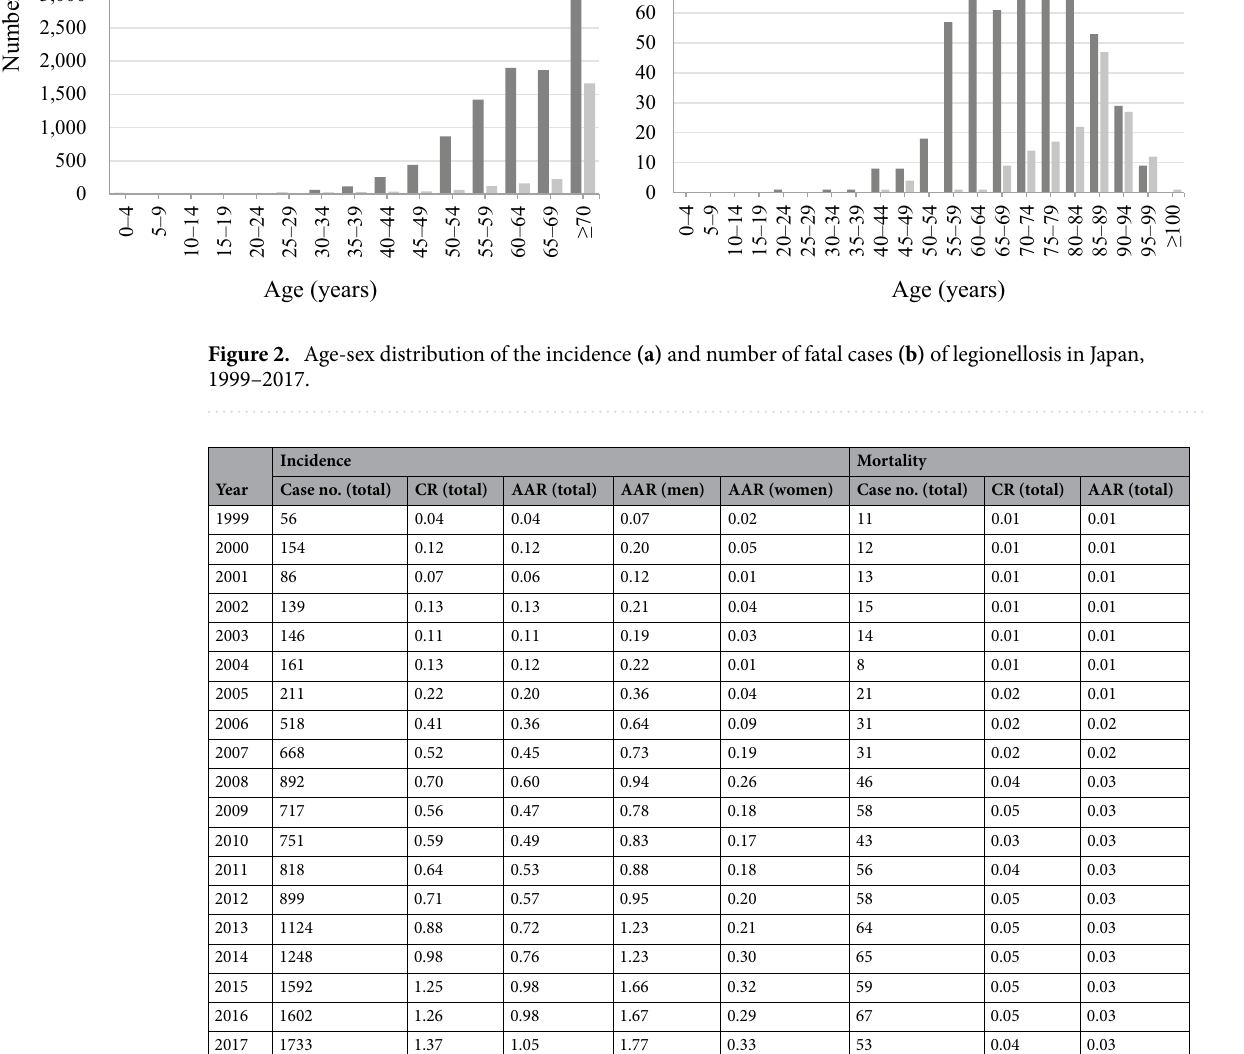
Seasonality of the incidence. Data between 2006 and 2017 (12 years) was applied for the seasonality comparison. Median numbers (interquartile ranges) of legionellosis incidence in winter, spring, summer, and autumn were 170 (135.25, 241); 197 (162, 289.5); 282.5 (241.75, 467.5); and 246.5 (190.75, 340), respectively. The Kruskal–Wallis test was used to calculate the P-value of < 0.001 among the 4 seasons, and Mann–Whitney U test with Bonferroni adjustment demonstrated a significant difference between winter and summer ( p = 0.013) Geographic distribution. We utilised the regional data (each of 47 prefectures in Japan) between 2013 and 2017 (the last 5 years). 2 maps (Fig. 4a,b) showing differences of the crude- and age-adjusted incidence rates of legionellosis. Data in detail are as summarised in the table (Supplementary Table S1). The incidence rates were highest in 3 prefectures in the Hokuriku District, with ≥ 2.0 per 100,000 population. Toyama Prefecture had the highest reported annual incidence rate of 3.49 per 100,000 population, followed by Ishikawa (2.81) and Fukui